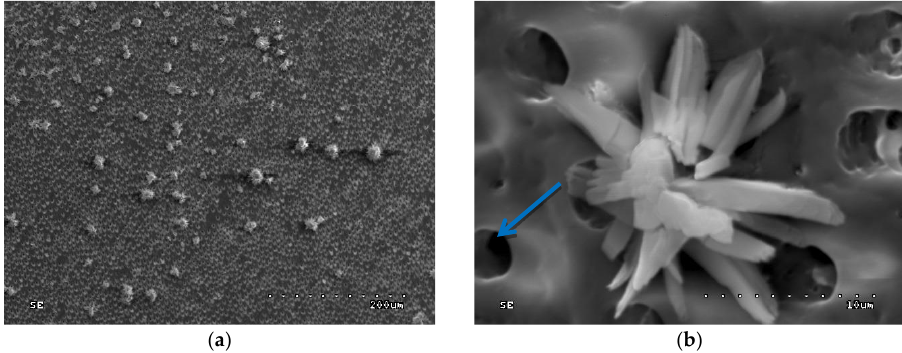
Figure 10. SEM image of acid-etched dentine surface after application of 2.0% CHG for 15 s—group 14: ( a ) 200×; ( b ) 5000×. Blue arrow shows open lateral dentinal tubule. ( a ) 200 × ; ( b ) 5000 × . Blue arrow shows open lateral dentinal